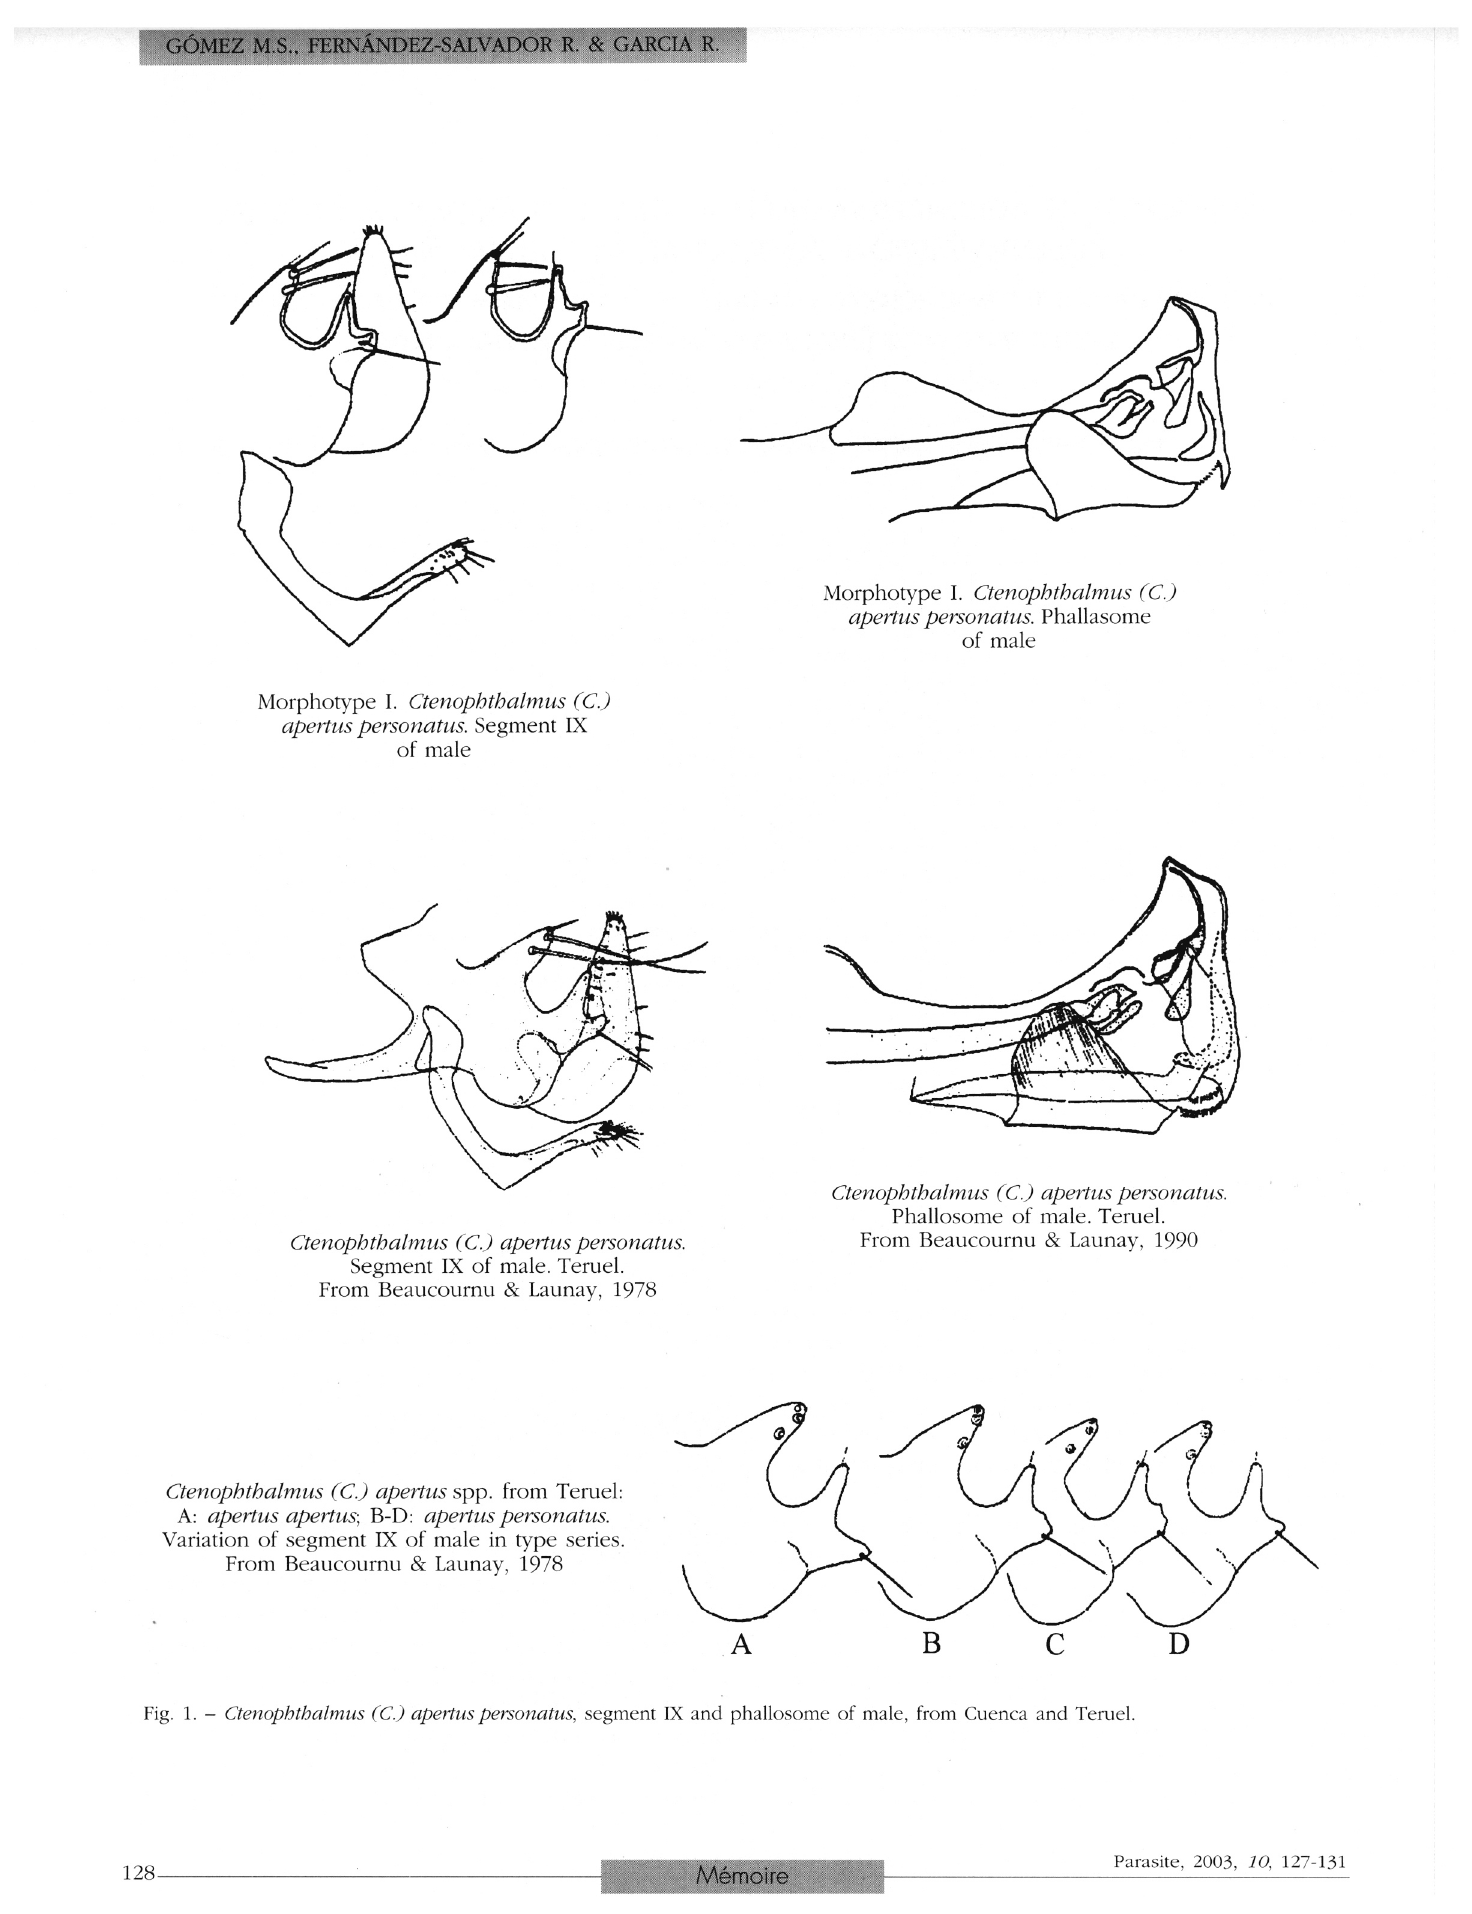
Fig. 1. - Ctenophthalmus (C.) apertus personatus, segment IX and phallosome of male, from Cuenca and